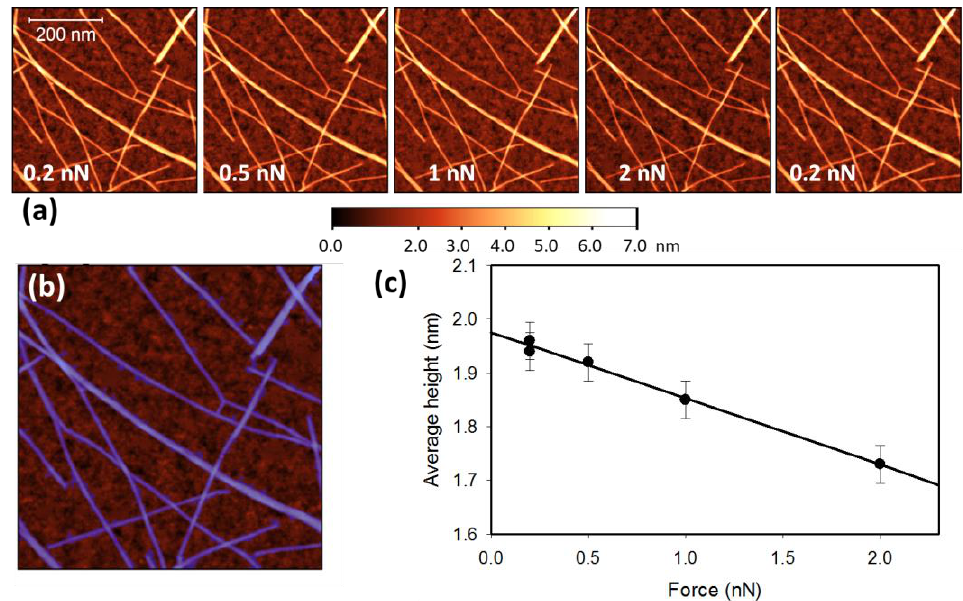
Figure 1. ( a ) Consecutive images of the same area of a PFDD/SWCNT network on a SiO 2 substrate, obtained at different peak-force feedback values. ( b ) The blue mask shows all the pixels whose height was included in obtaining the average network height. ( c ) Average network height as a function of applied force along with a linear fit to the data.